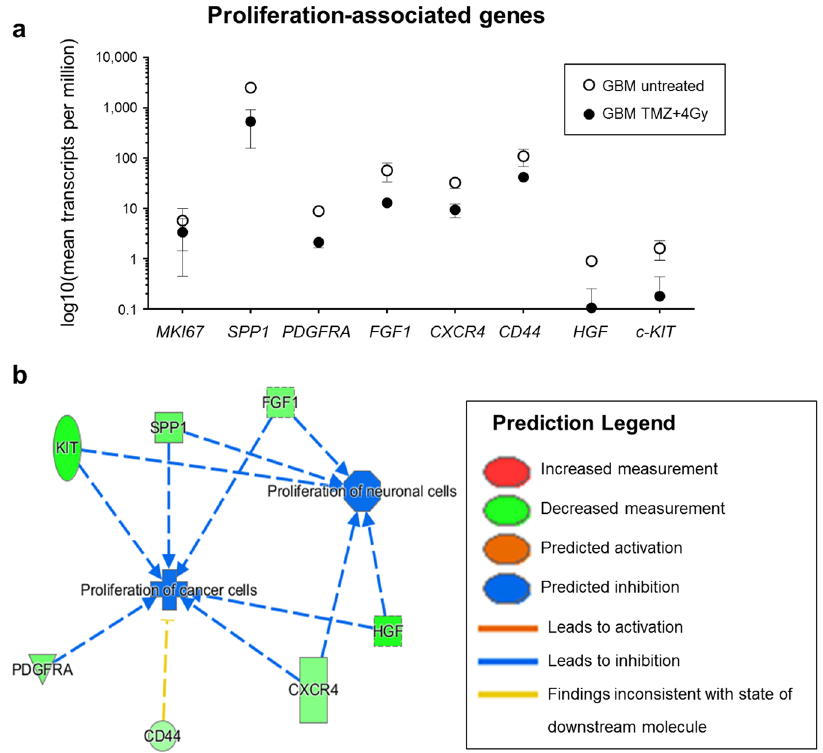
Figure 5. mRNA expression indicates an inhibition of proliferation after treatment. The differentially expressed transcripts in treated versus untreated GBM tissue were compared to a list of proliferation-associated genes obtained from the Ingenuity ® Pathway Analysis (IPA ® , QIAGEN). 190 genes were found to be present in both lists. Transcripts per million of some of these genes are displayed in ( a ). Knowledge base analysis with IPA ® indicates an inhibition of proliferation of neuronal and cancer cells ( b , blue lines). Green symbols represent a decreased measurement of the respective